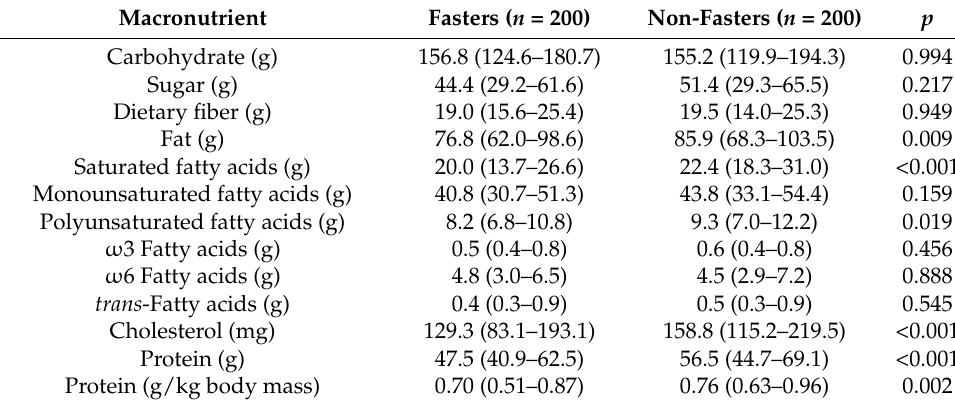
Table 1. Daily macronutrient intakes by fasters and non-fasters, based on three-day dietary records (median and interquartile